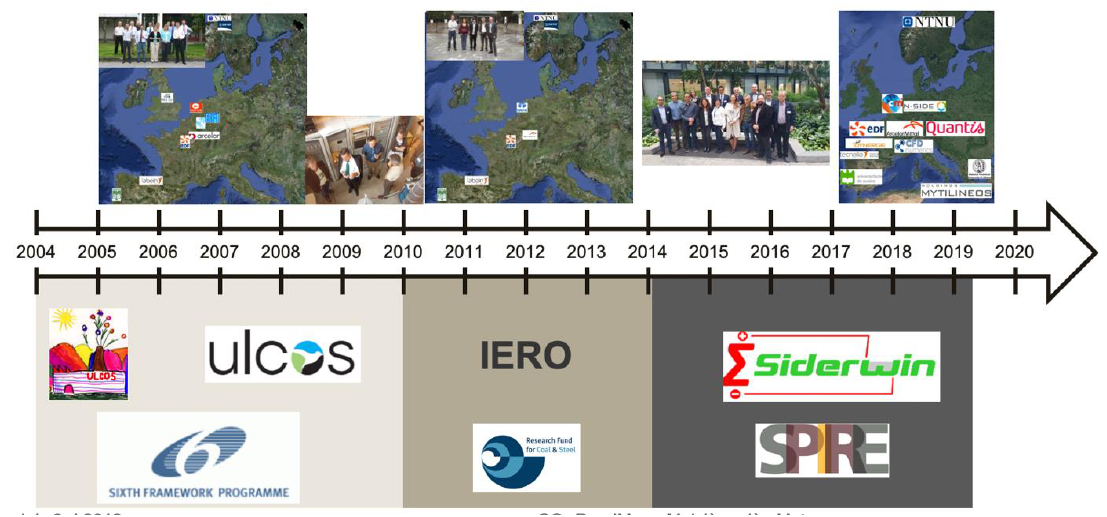
Figure 23. Evolution of the low-temperature electrolysis of iron ore, known as ULCOLYSIS and now as SIDERWIN (courtesy of ArcelorMittal).